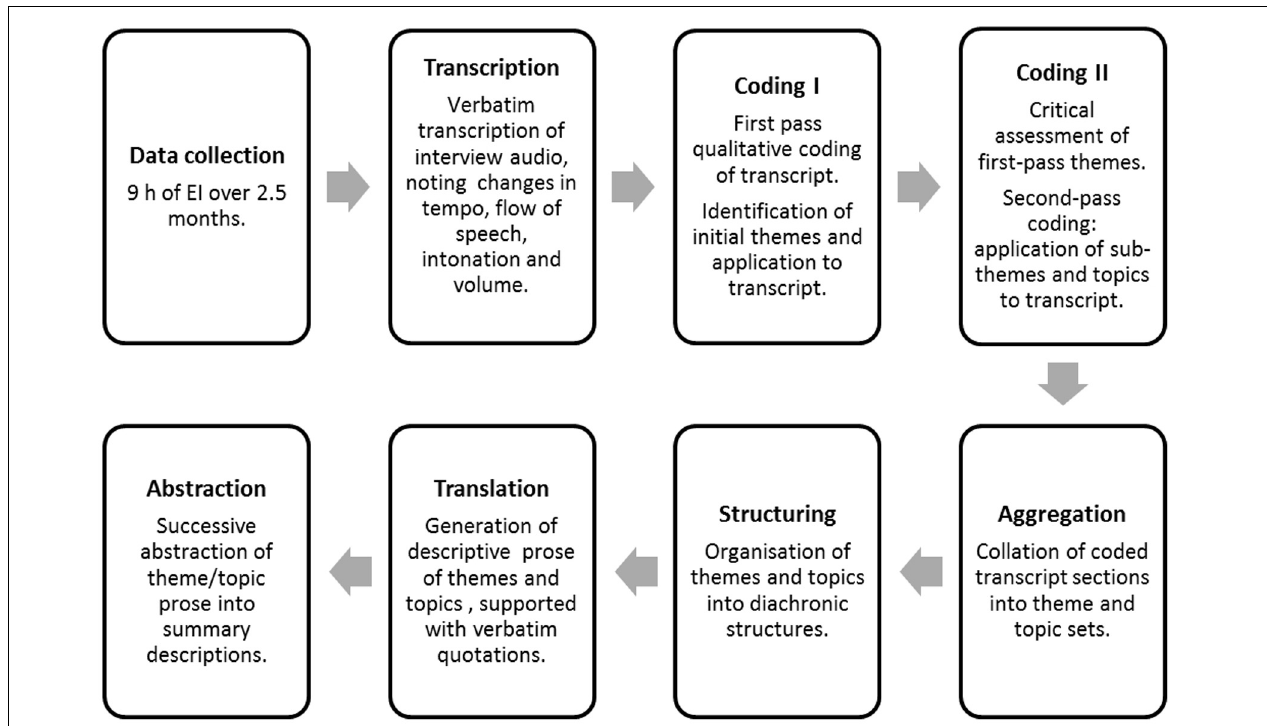
FIGURE 3 | Schematic of data collection and analysis